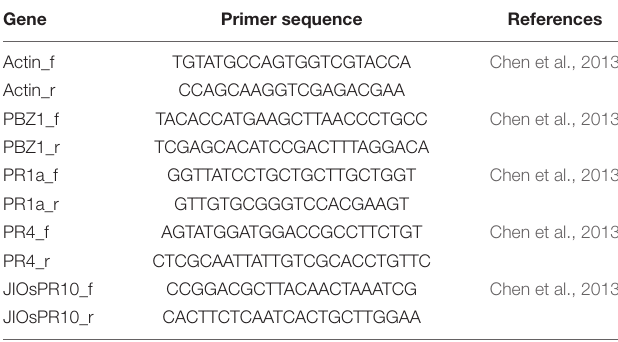
TABLE 3 | List of primer sequences for